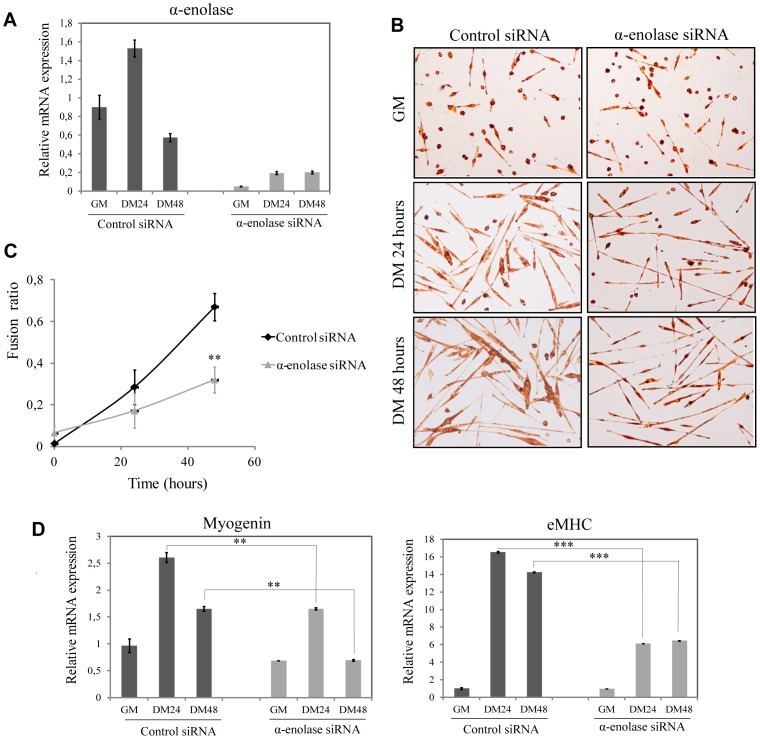
Knockdown of α-enolase by siRNA reduces MPCs differentiation.
A. qRT-PCR to determine the relative mRNA quantity of α-enolase after siRNA transfection. B. Immunocytochemical staining for eMHC of MPCs transfected with α-enolase siRNA or control siRNA, on GM and DM at 24 and 48 hours. C. Quantification of the Fusion ratio (n° eMHC positive cells fused in a myotube >4 nuclei/total cells) or Myogenic Index. ** P<0.005. D. qRT-PCR to determine relative mRNA quantity of the genes for myogenin and eMHC. Ribosomal protein L32 mRNA levels were used for normalization. ** P<0.01, *** P<0.005. Results are the mean +/− SEM (error bars) of three different experiments.